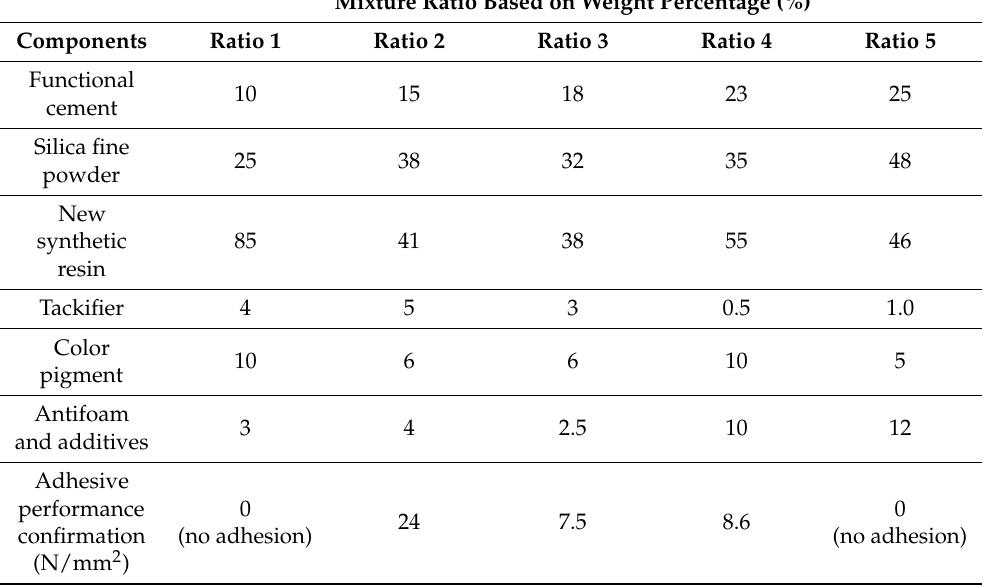
Table 1. Adhesive performance assessment based on different component mixture ratios of modified latex acrylic